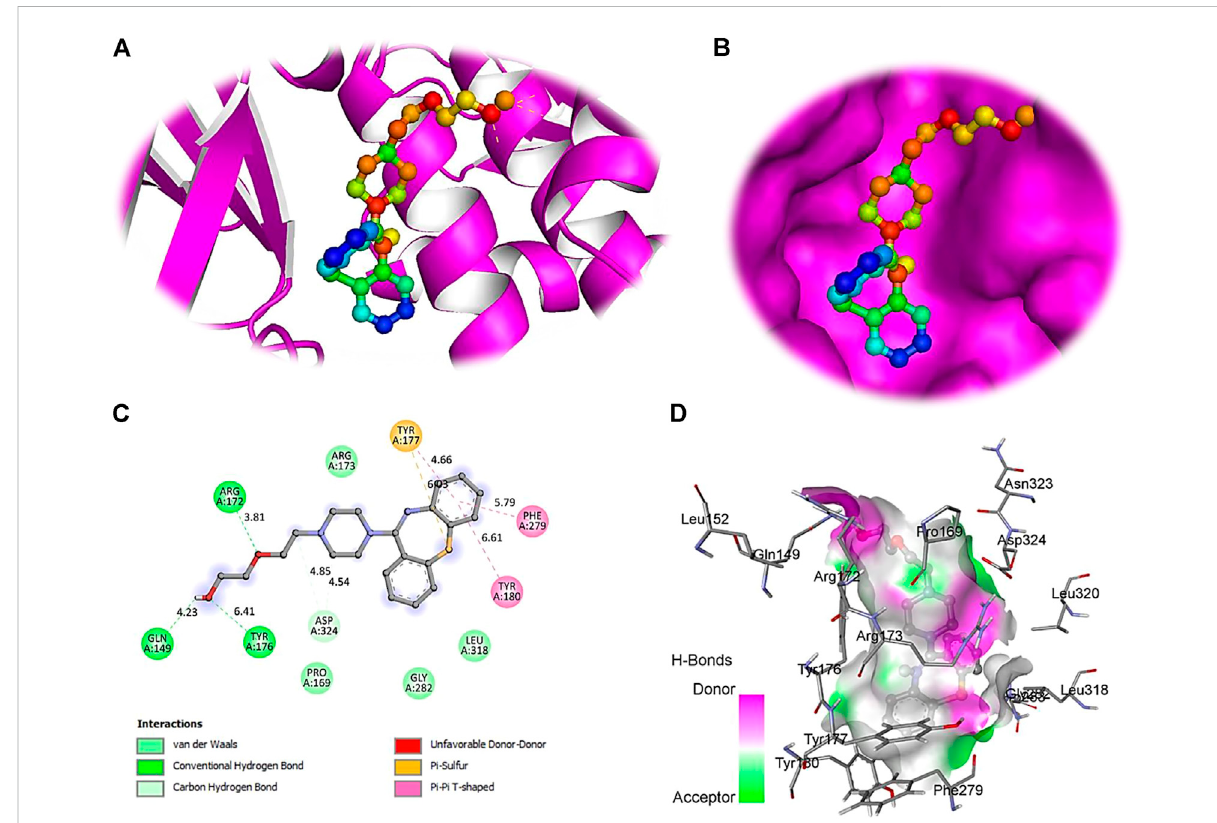
FIGURE 6 ThecrystalstructureofPTENincomplexwithQuetiapine. (A) AcartoonrepresentationofPTENcomplexcloseview. (B) Surfacerepresentation of PTEN in complex with Quetiapine is represented in sticks-boll form. (C) A close view of substrate binding pocket representing the key amino acid residues forming interactions with inhibitor molecule. (D) Surface representation of conserved substrate-binding pocket of